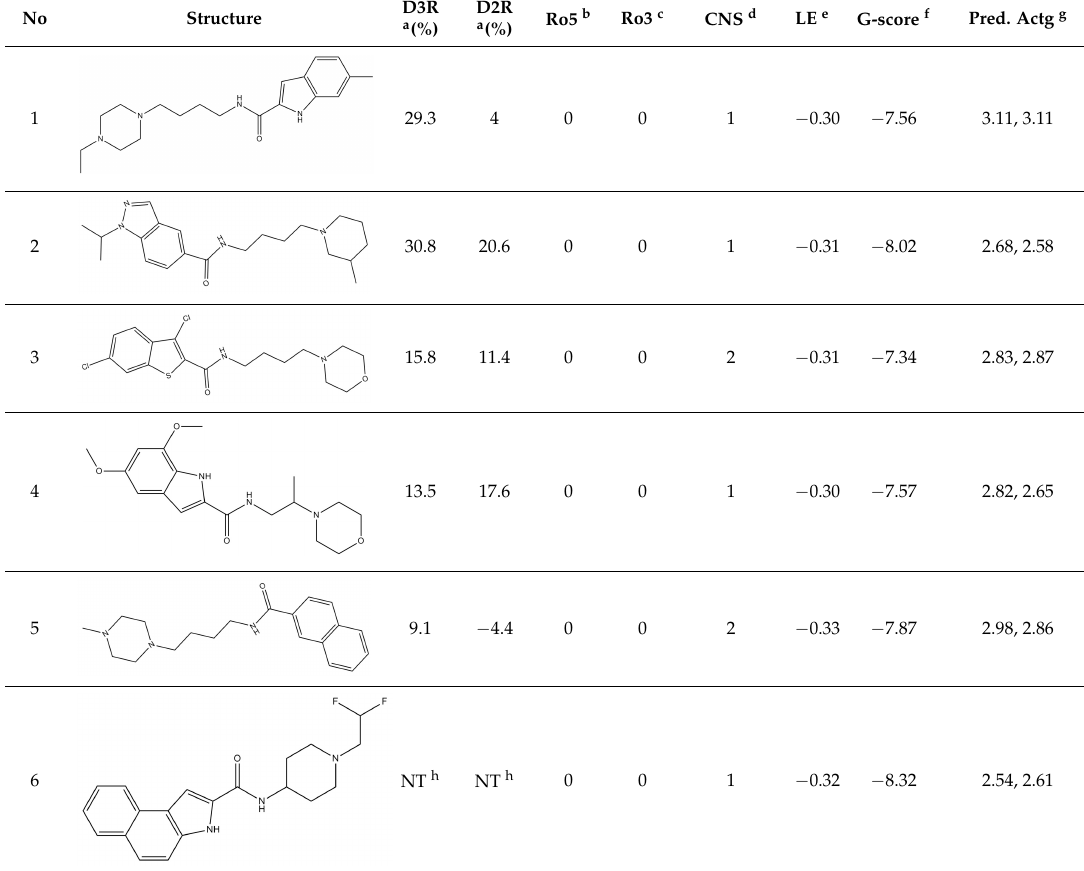
Table 3. Structure, estimated efficacy and ADME properties of selected hit compounds.